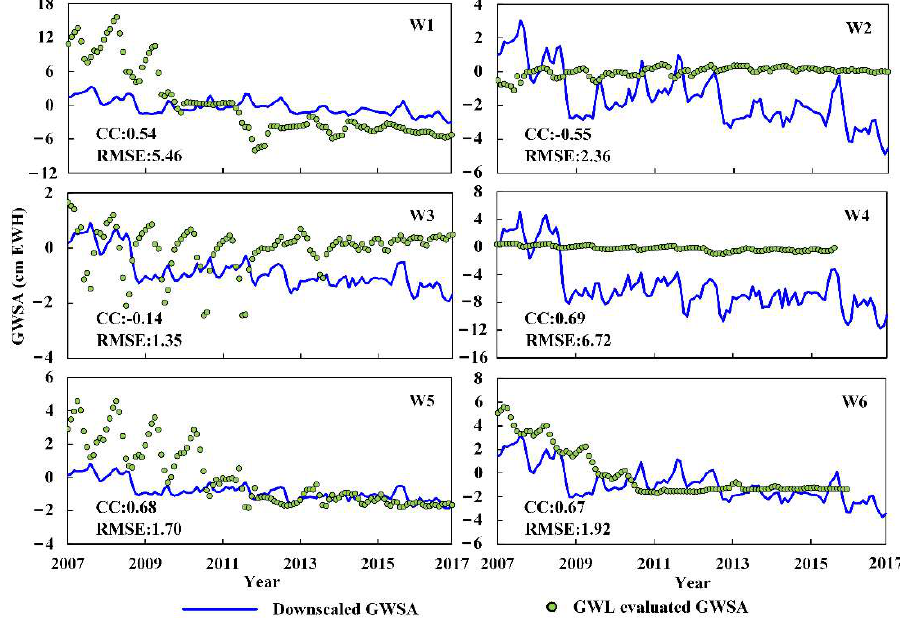
Figure 8. Comparison of time-series groundwater storage changes from the model and field obser- vation.